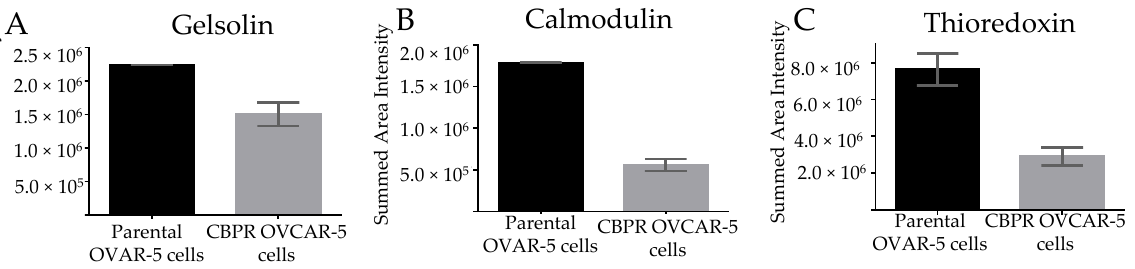
Figure 5. DIA analysis of parental OVCAR-5 cells compared to CBPR OVCAR-5 cells. Relative quan- ti fi cation of gelsolin p value = 0.027 ( A ), calmodulin p value = 0.0017 ( B ), and thioredoxin p value = 0.021 ( C ) in biological replicates of parental OVCAR-5 cells compared to CBPR OVCAR-5 cells. Graphs show the standard error of the mean and signi fi cance was calculated using an unpaired t - test.